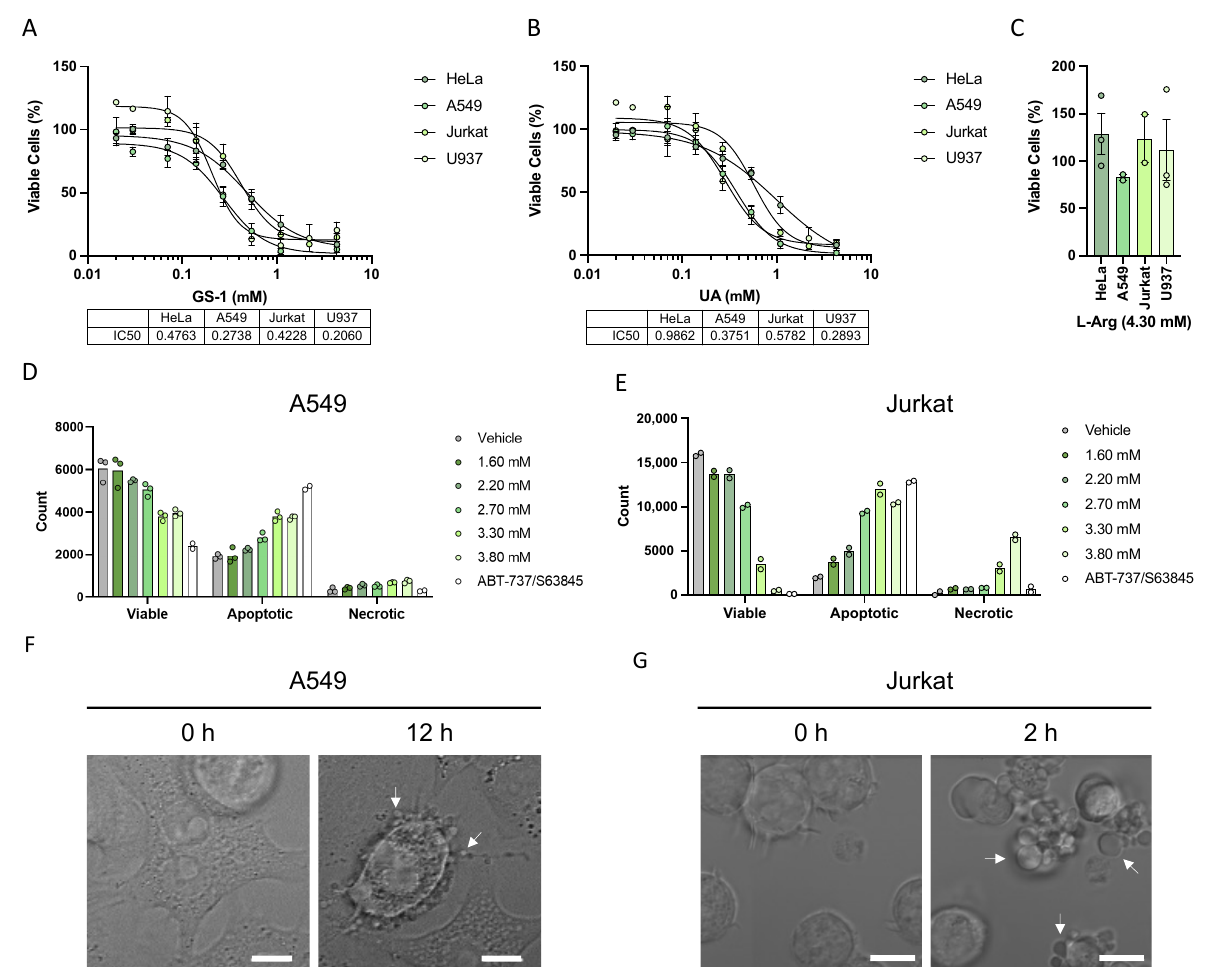
Figure 2. GS-1 induces apoptosis in tumor cells in vitro. HeLa, A549, Jurkat, and U937 cells were treated with increasing concentrations of ( A ) GS-1, ( B ) UA, or ( C ) 4.3 mM L-Arg for 24 h before undergoing MTT or MTS assays to determine viability as a percentage of vehicle controls (n = 2–3, mean ± S.E.M.). A549 cells were treated with GS-1 for 6 h and ( D ) Jurkat cells for 3 h ( E ) before flow cytometry analysis with Annexin V and To-Pro-3 to determine viable, apoptotic, and necrotic cell populations (representative of n = 3 experiments, mean). Bright field imaging of ( F ) A549 cells treated with GS-1 at 2.7 mM and ( G ) Jurkat cells treated with GS-1 at 2 mM (scale bars 10 µ m; images representative of 3 experiments).